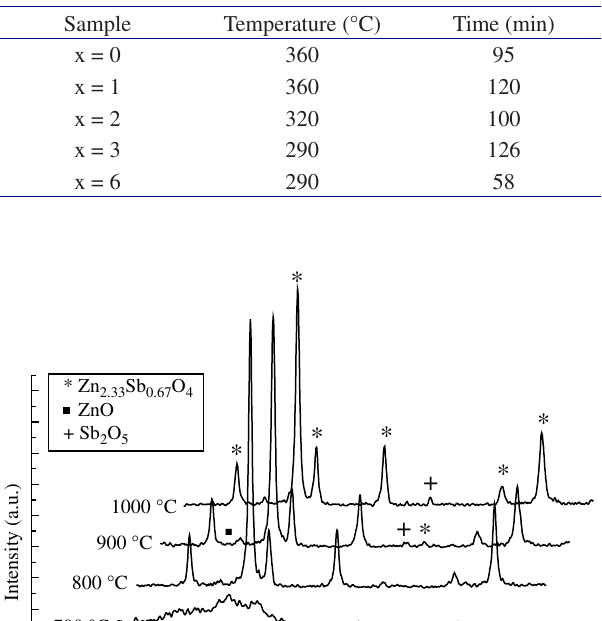
Table 2. Calcination time and temperature for carbon reduction.